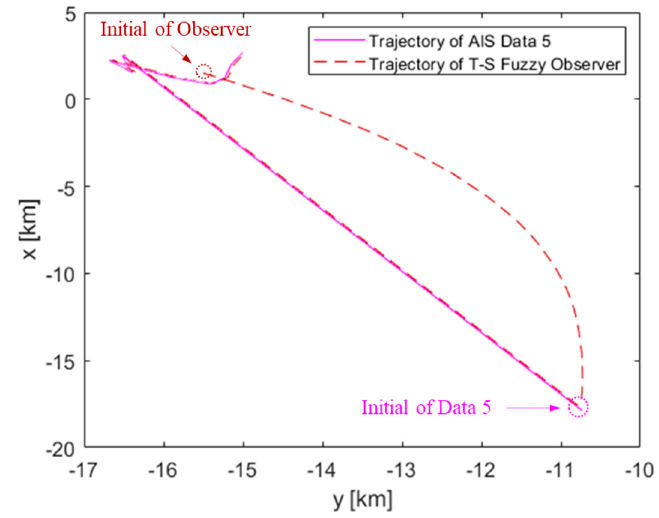
Figure 19. Observed results of AIS data 5.